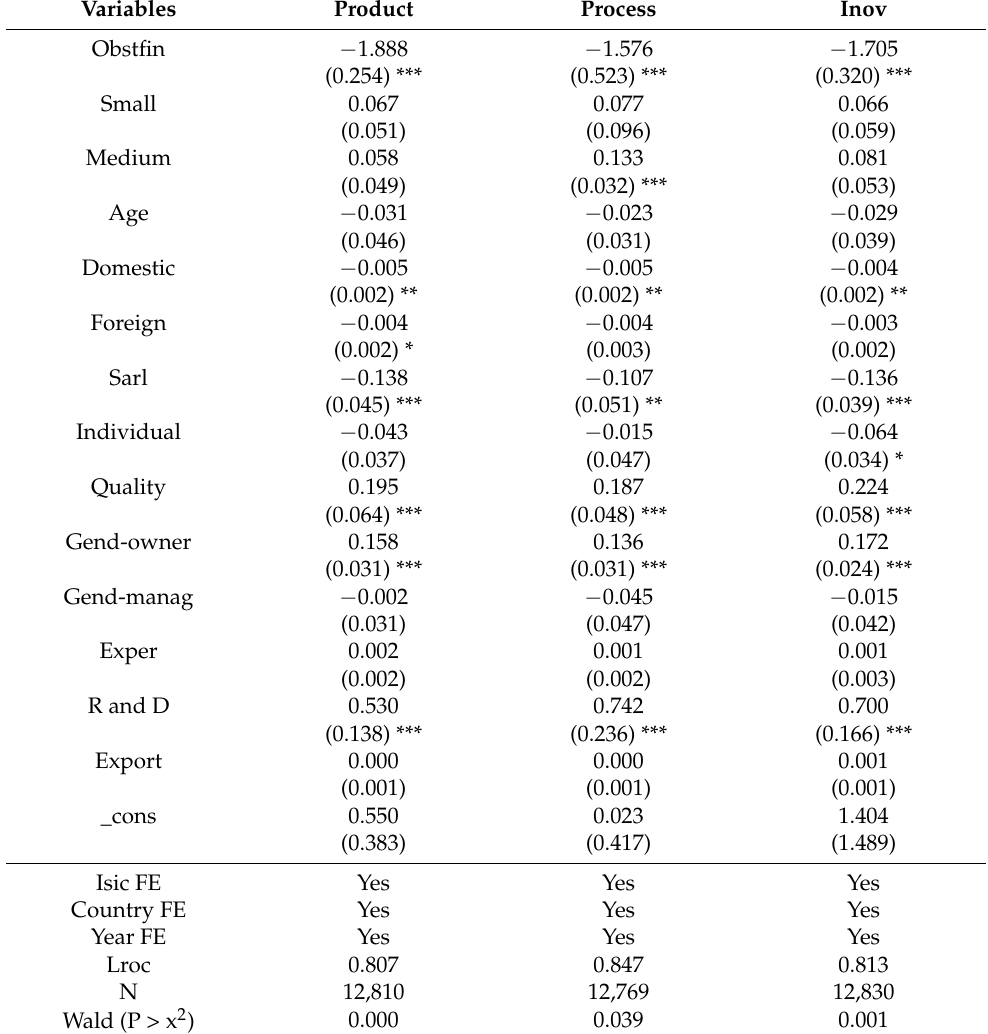
Table 5. IV-probit regression of financial barriers to